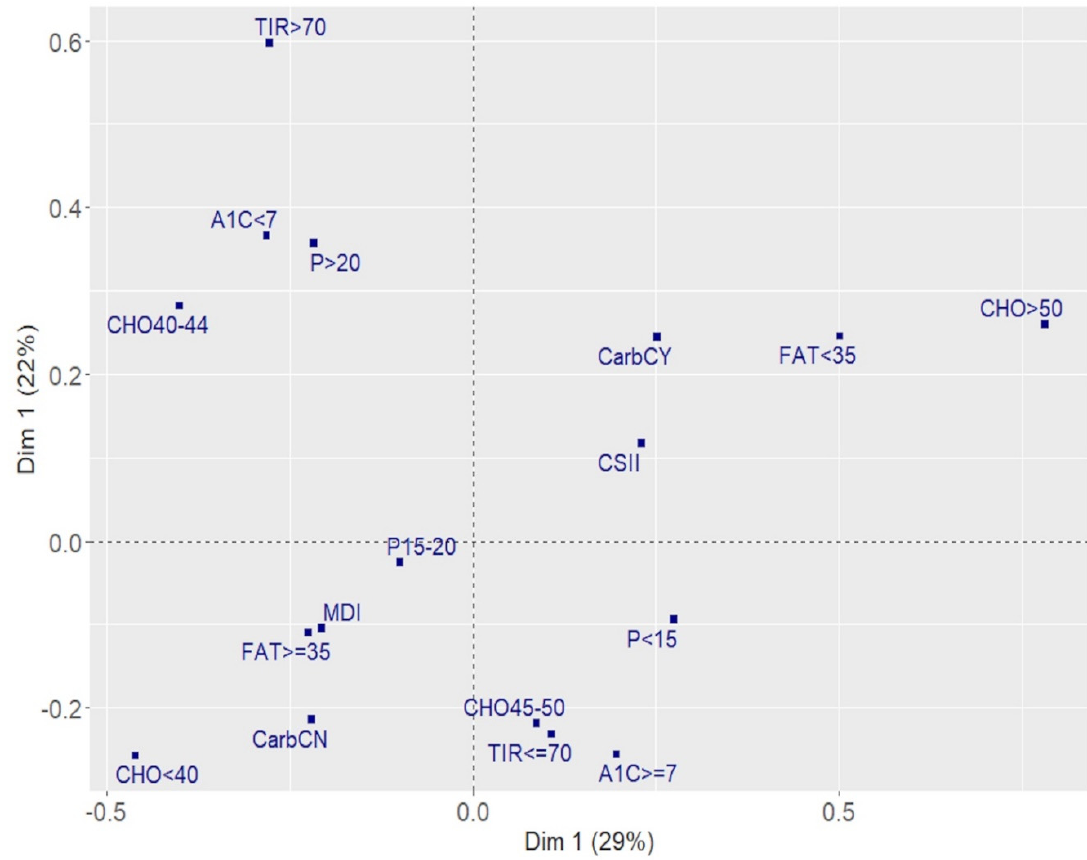
Figure 1. Associations between nutrients and metabolic control. Results of the multiple correspondence analysis. A1c > 7: HbA1c > 7% (53 mmol/mol); A1c < 7: HbA1c ≤ 7% (53 mmol/mol); CSII: insulin pump; MDI: multiple daily injection;